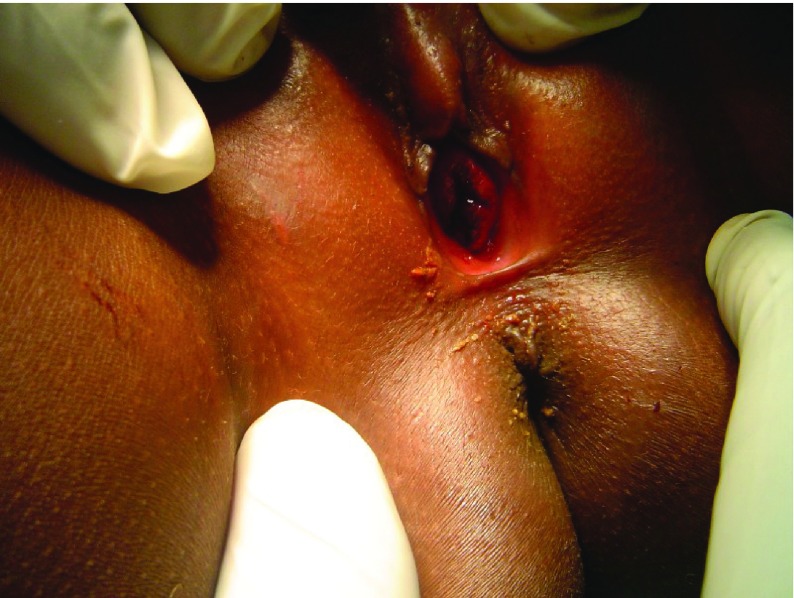
Urethral Prolapse